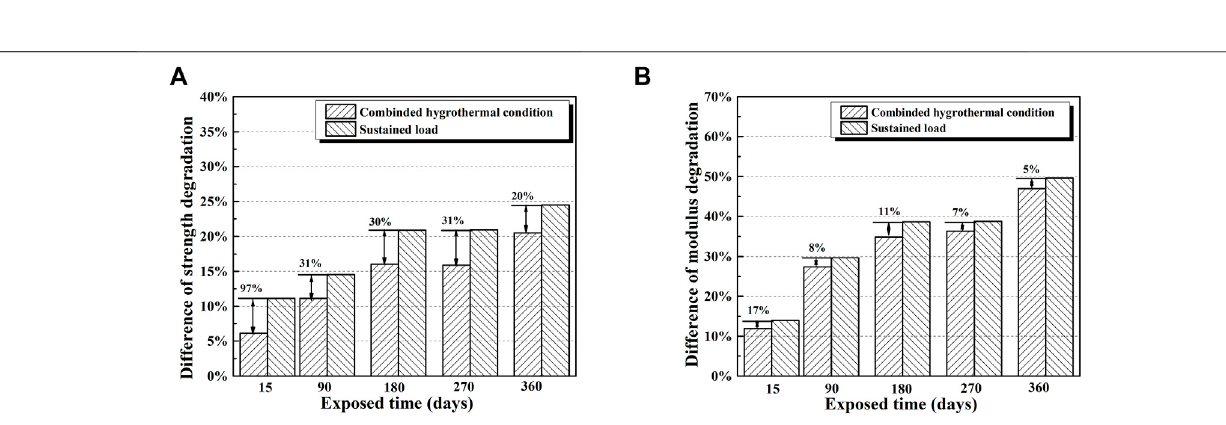
Frontiers in Materials |